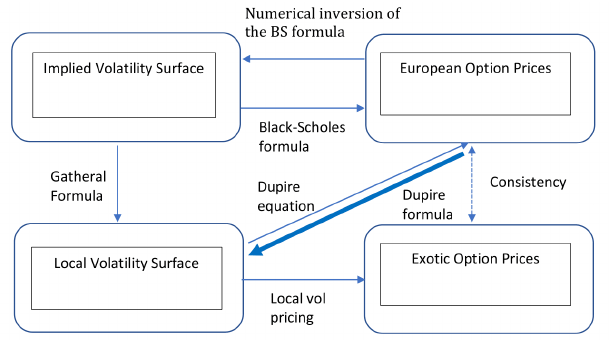
Figure 1. Mathematical connections between option prices, implied, and local volatility, and the goal of this paper, namely to use the Dupire formula with deep neural networks to jointly approximate the vanilla price and local volatility